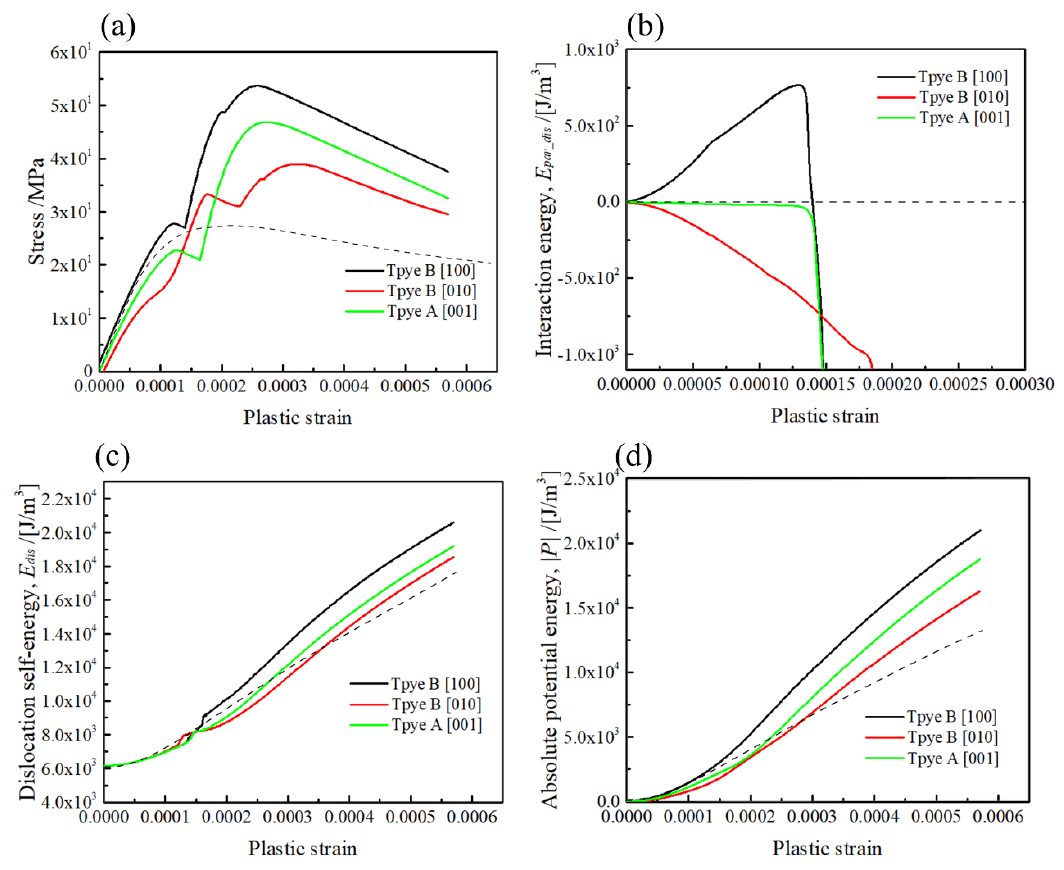
Figure 10. Comparisons of the dislocation interactions computed for the three different {001} rod precipitates at z/|b| = 0. ( a ) Stress–strain curve, ( b ) interaction energy between the precipitate and dislocation, ( c ) interaction energy of the dislocations, ( d ) potential energy due to the dislocation motion. Dotted lines indicate the profiles computed for the dislocation motion without a precipitate.